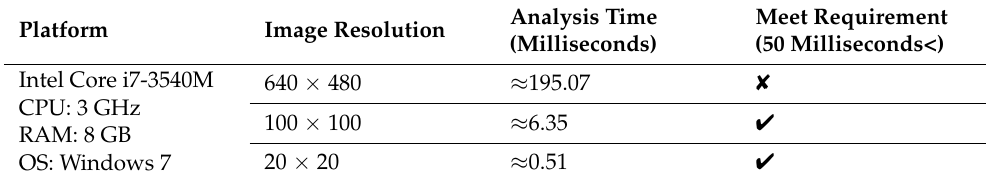
Table 3. Image analysis